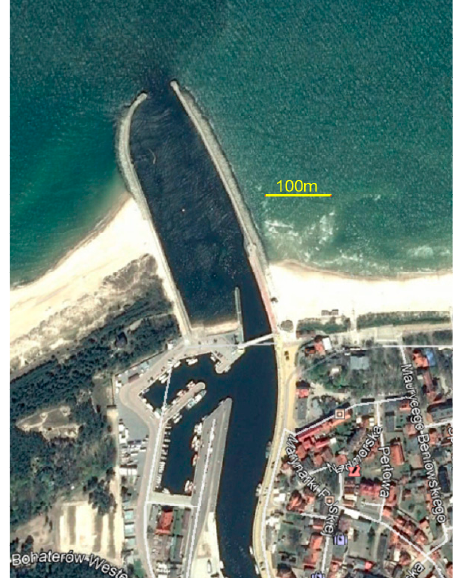
Figure 1. Ustka Port—the present